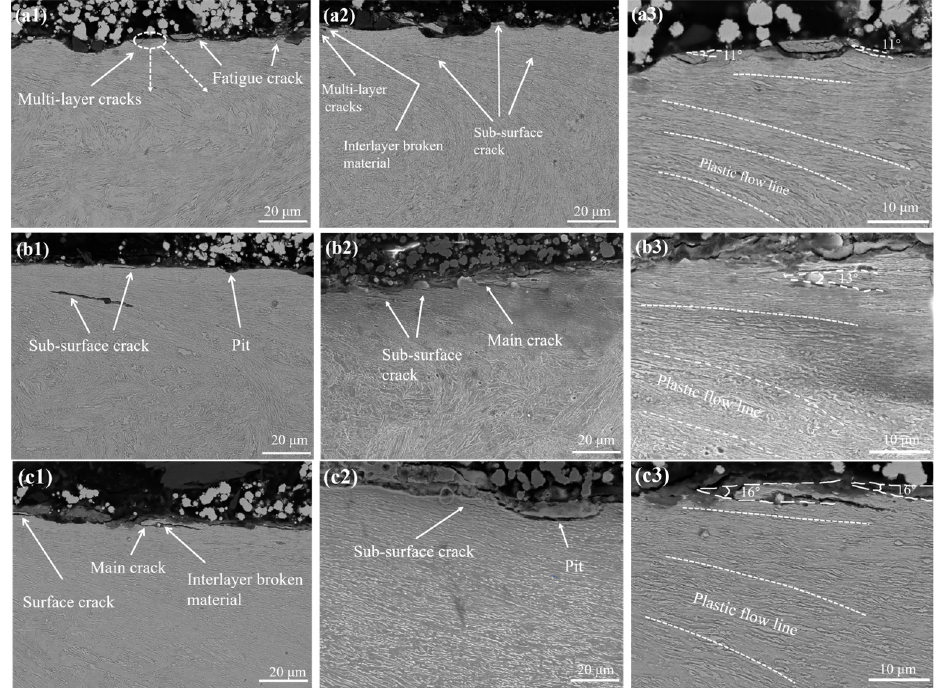
Figure 10. FESEM images of the fatigue cracks on the surface of the test steel: ( a1 – a3 ) 80 km/h, ( b1 – b3 ) 120 km/h and ( c1 – c3 ) 150 km/h.